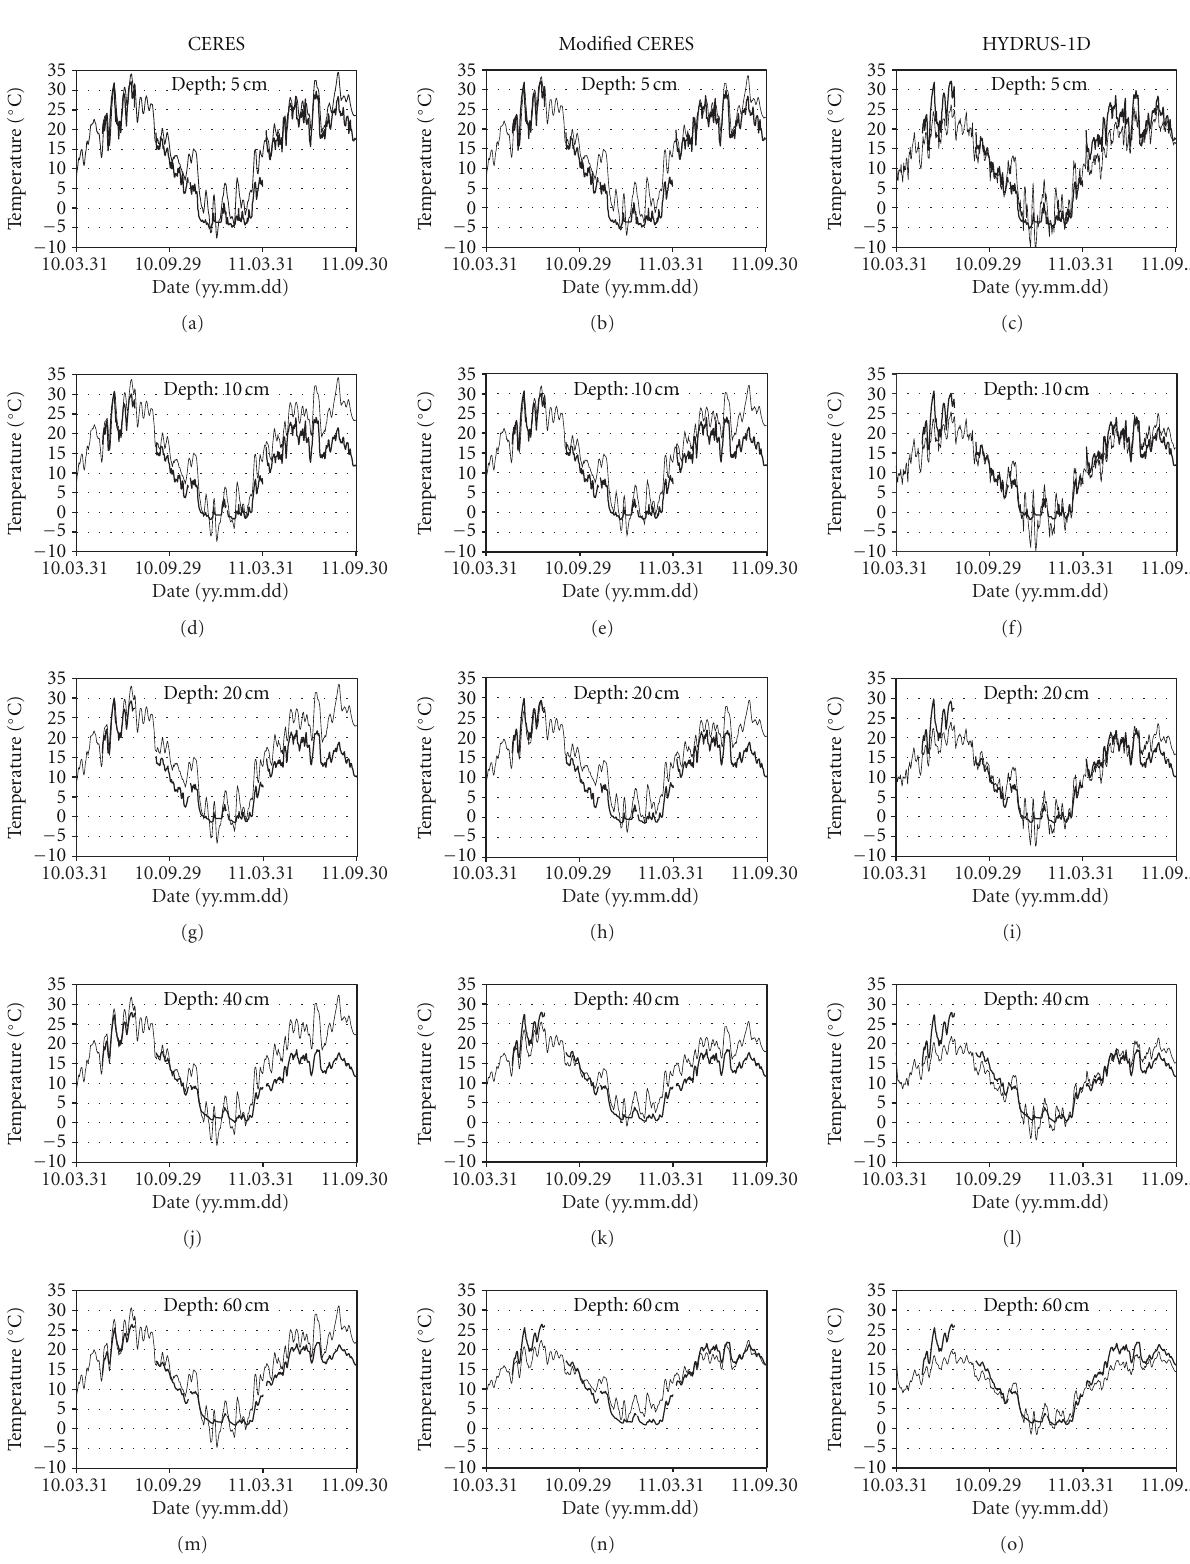
Figure 3: Series of measured and calculated soil temperature values at di ff erent depths, at ˝Orbotty´an, Hungary. Thick lines—measured, thin